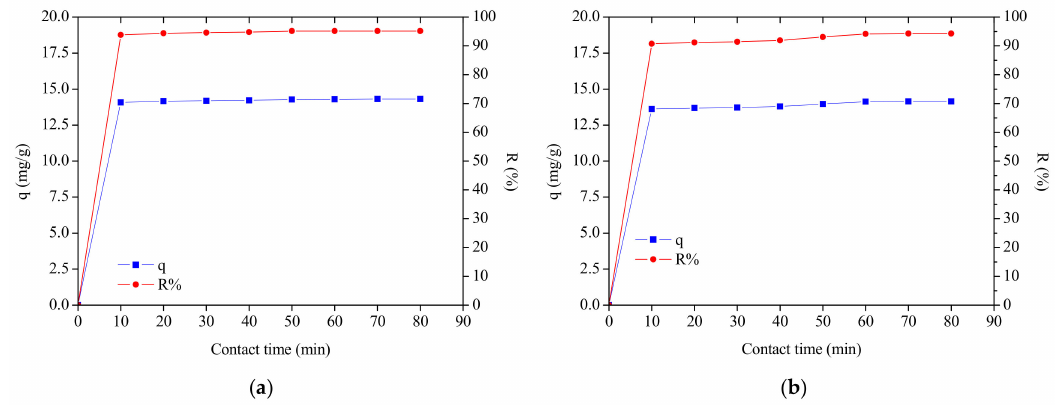
Figure 10. Contact time vs. percentage of removal vs. biosorption capacity: ( a ) PMT and ( b ) CCLHR.